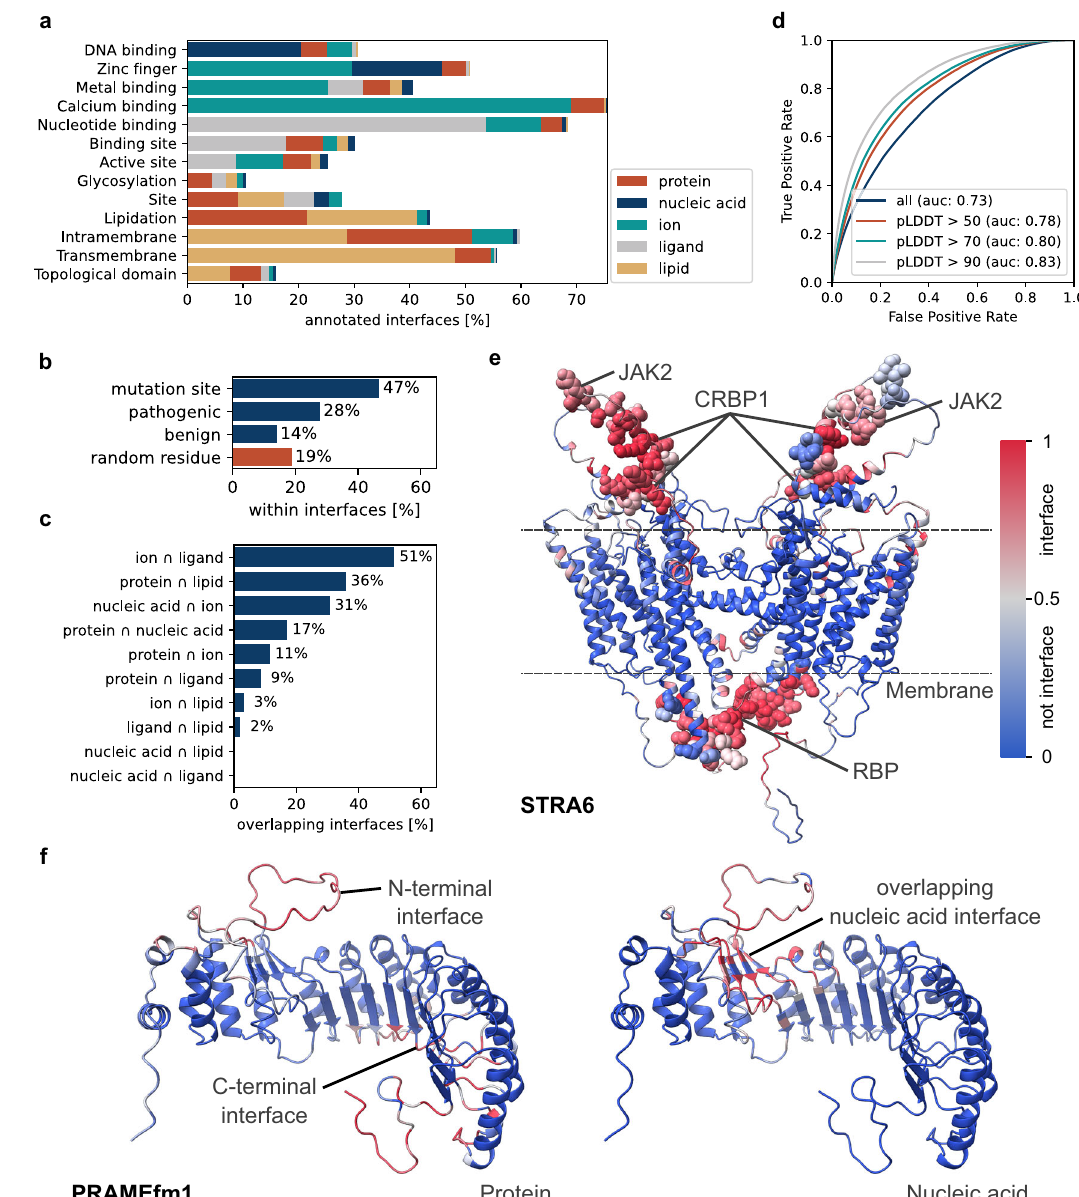
Fig. 4 | PeSTo-based analysis of the human proteome. a Percentage of entries with speci fi c UniProt features for which PeSTo predicts an interaction interface at the annotated sequence region. b Percentage of sites with mutations, pathogenic or benign natural variants within a predicted inter- face. The baseline is the probability of a random residue being within an interface. c Percentage of overlapping interfaces for all 10 pairs of fi ve interface types. d Comparison of predicted protein-binding interfaces from PeSTo using the models of yeast protein complexes predicted by Humphreys